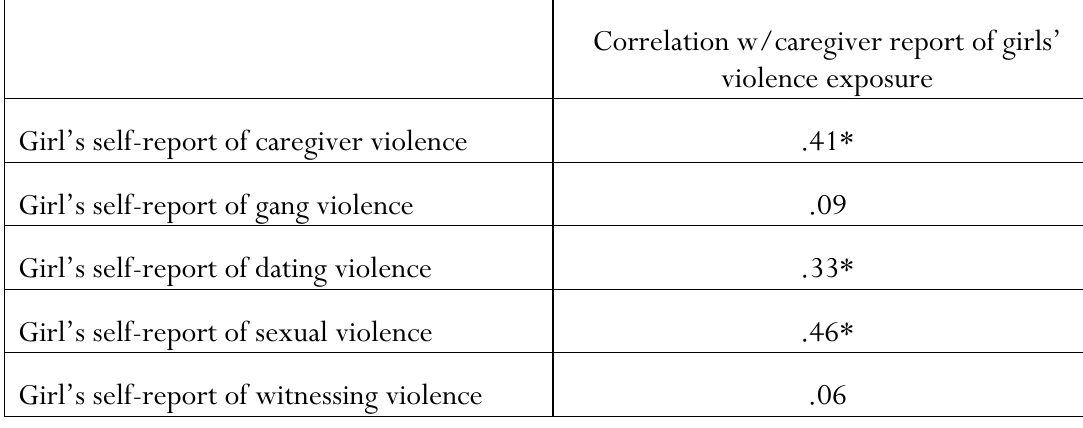
Table 2: Associations between Caregivers’ & Girls’ Responses Regarding Girls’